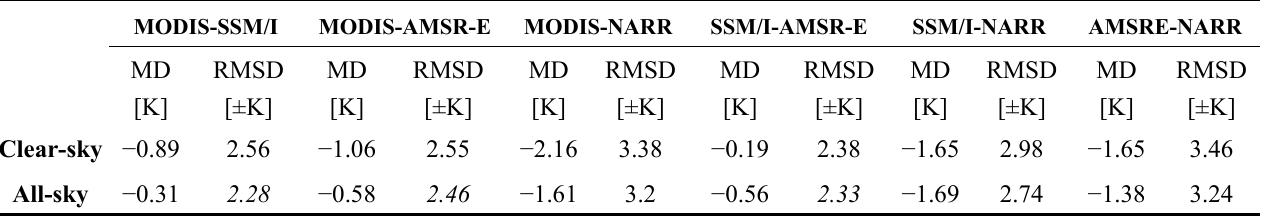
Table 4. Summary of bias statistics during the snow-free period (July and August 2007) between MODIS and other products for clear-sky and all-sky conditions.